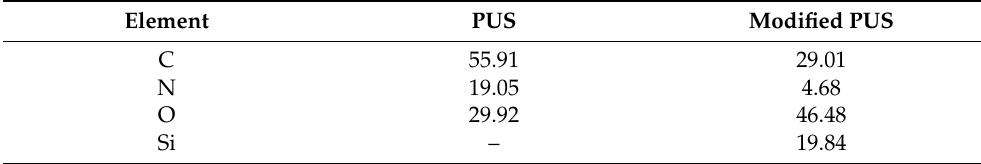
Figure 10. Element mapping of the ( a ) PUS and ( b ) modified PUS. Table 5. The elemental composition (the ratio of atom, %) of PUS and modified PUS.